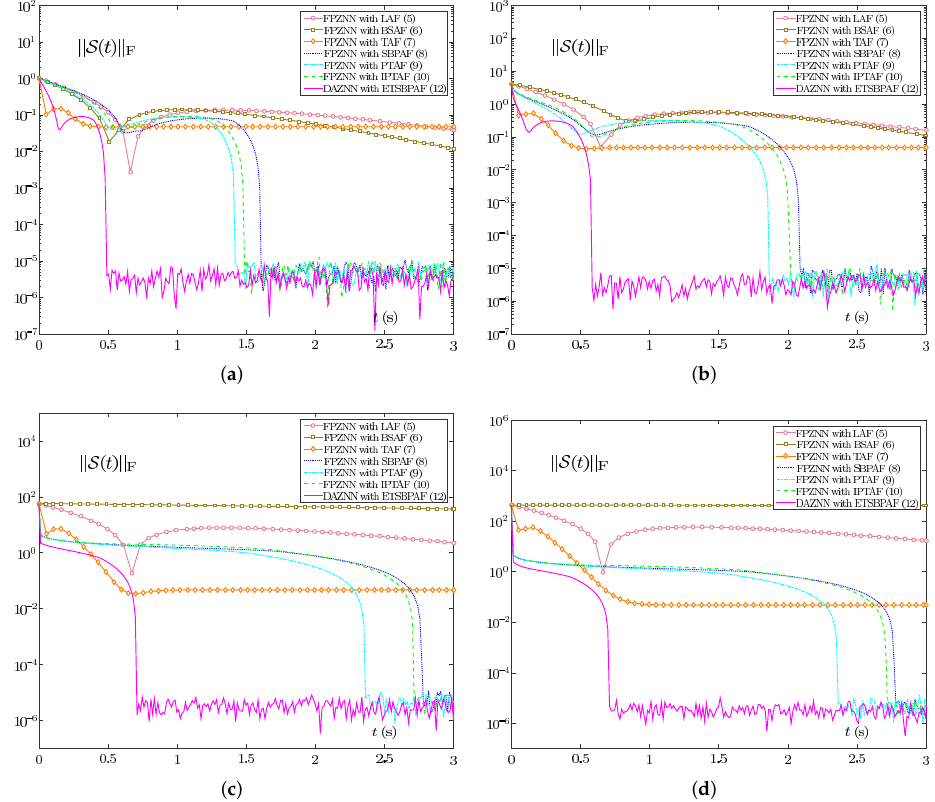
Figure 6. Dynamic characteristics of the (cid:107)S ( t ) (cid:107) F by FPZNN model (4) and DAZNN model (14) in different initial values X ( 0 ) . ( a ) X ( 0 ) ∈ [ − 0.7,0.7 ] 2 × 2 . ( b ) X ( 0 ) ∈ [ − 4,4 ] 2 × 2 . ( c ) X ( 0 ) ∈ [ − 70,70 ] 2 × 2 . ( d ) X ( 0 ) ∈ [ − 400,400 ] 2 × 2